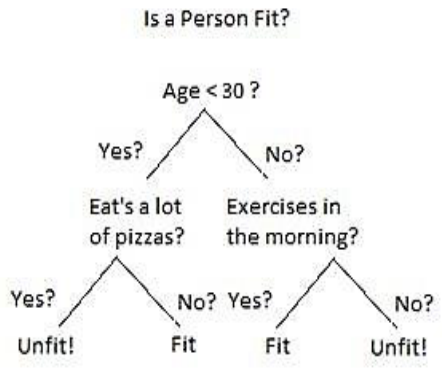
Figure 2. Decision tree classification for a persons’s fitness